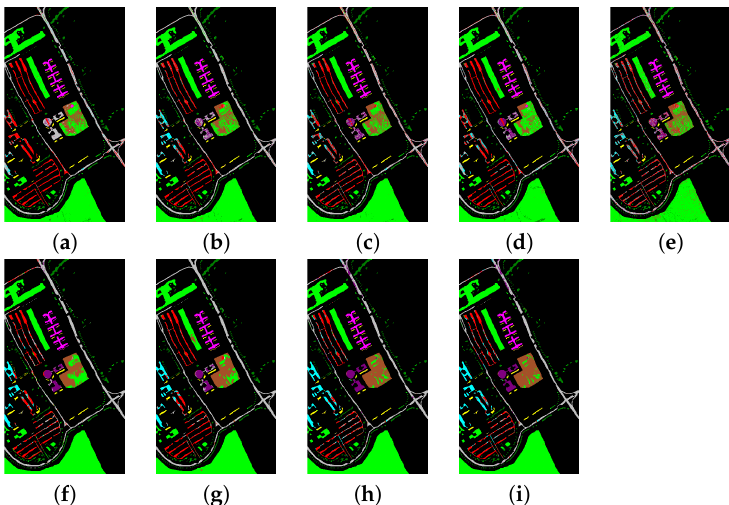
Figure 7. Classification maps for the Pavia University data set using the compared methods and the proposed method. ( a ) SVM; ( b ) NRS; ( c ) CRT; ( d ) KCRC; ( e ) OMP; ( f ) SOMP; ( g ) JRSRC; ( h ) 3D-CNN; ( i )